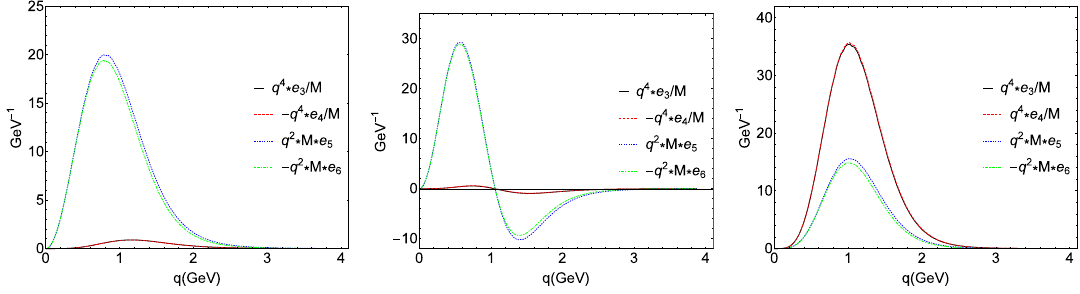
Figure 5 . The 3 − wave functions of the B ∗ mixture B ∗ (1 G ) (right). e 3 and e 4 terms are G waves; e 5 and e 6 terms are D c 3